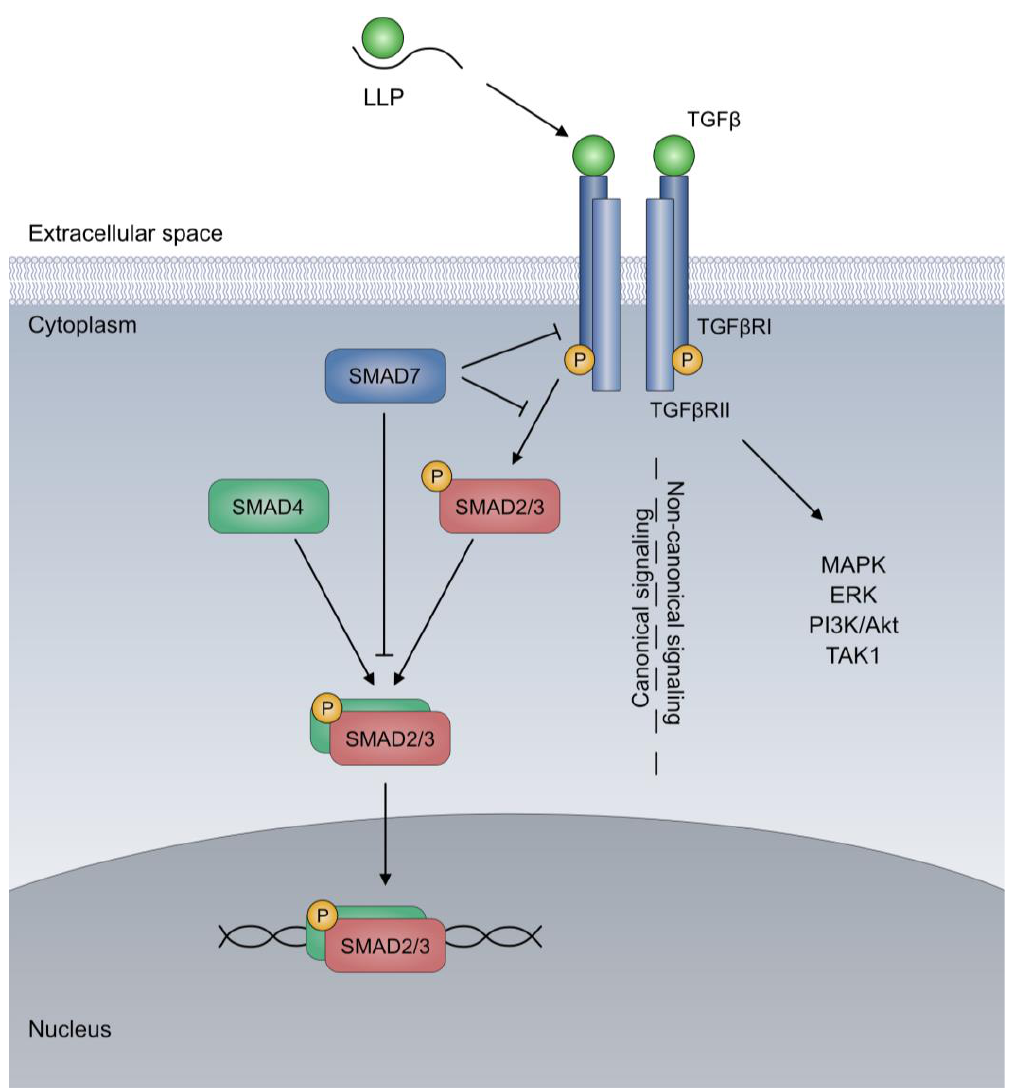
Figure 1. TGFβ signaling pathway. Following the release from the large latent complex (LLP), TGFβ dimers binds to the heteromeric TGFβ receptor, which consists of type I and type II receptors (such as TGFβRI and TGFβII). Within canonical signaling, this results in receptor phosphorylation with the subsequent activation of the receptor activated SMAD molecules (R-SMADs), such as SMAD2 or SMAD3. Phosphorylated R-SMADs form a heteromeric complex with SMAD4, which translocates to the nucleus and induces the transcription of target genes. Inhibitory SMADs (I-SMADs) such as SMAD7 can inhibit TGFβ signaling at several points. In non-canonical TGFβ signaling, TGFβ receptor activation results in the activation of mitogen-activated protein kinase (MAPK), extracellular signal-regulated kinase (ERK), phosphatidylinositol-3 kinase (PI3K)/Akt, TGFβ-activated kinase- 1 (TAK1) pathways, and others. The figure has been adapted from [9].